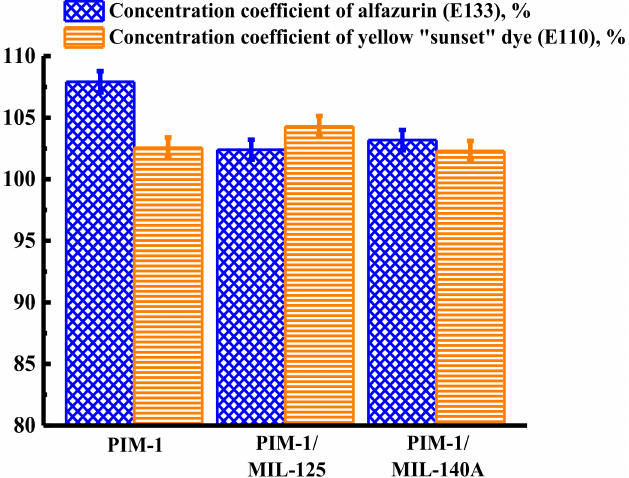
Figure 10. Concentration coefficient of alfazurin (E133) and yellow “sunset” dye (E129) solutions at 40 atm for unmodified and modified membranes.